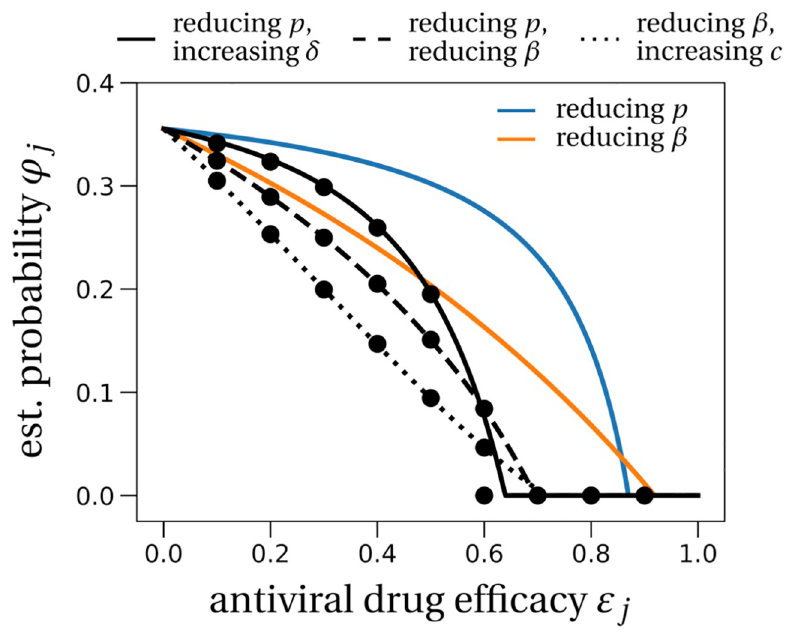
Fig 3. The effect of prophylactic combination therapy on the establishment probability. We compare different combination therapies (black lines) with the two single effect therapies (colored lines). The theoretical predictions for the combination therapies are variations of Eq (8), adapted to the specific pair of modes of action considered. We assume that both modes of action are suppressed with the same efficacy, shown on the x-axis as ε j . Dots are averages (0) = 1. In Section E in S1 Text, we study the from 100, 000 stochastic simulations using the LowN parameter set and V I effect of combination therapy in the HighN parameter set which overall leads to very similar